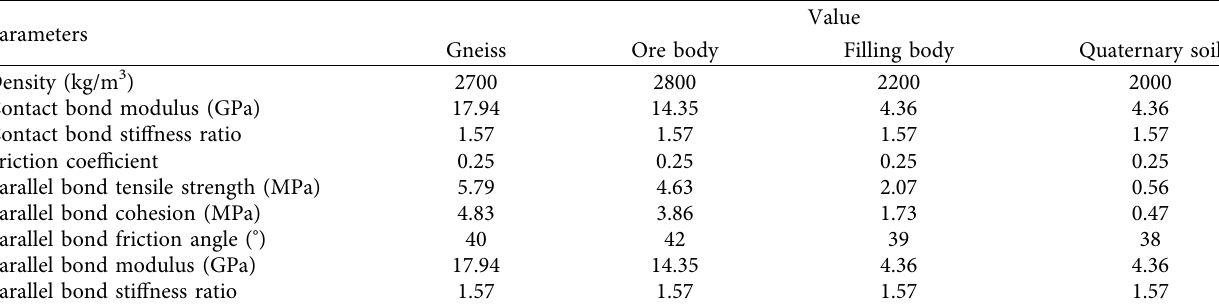
Table 2: Microscopic parameters of the